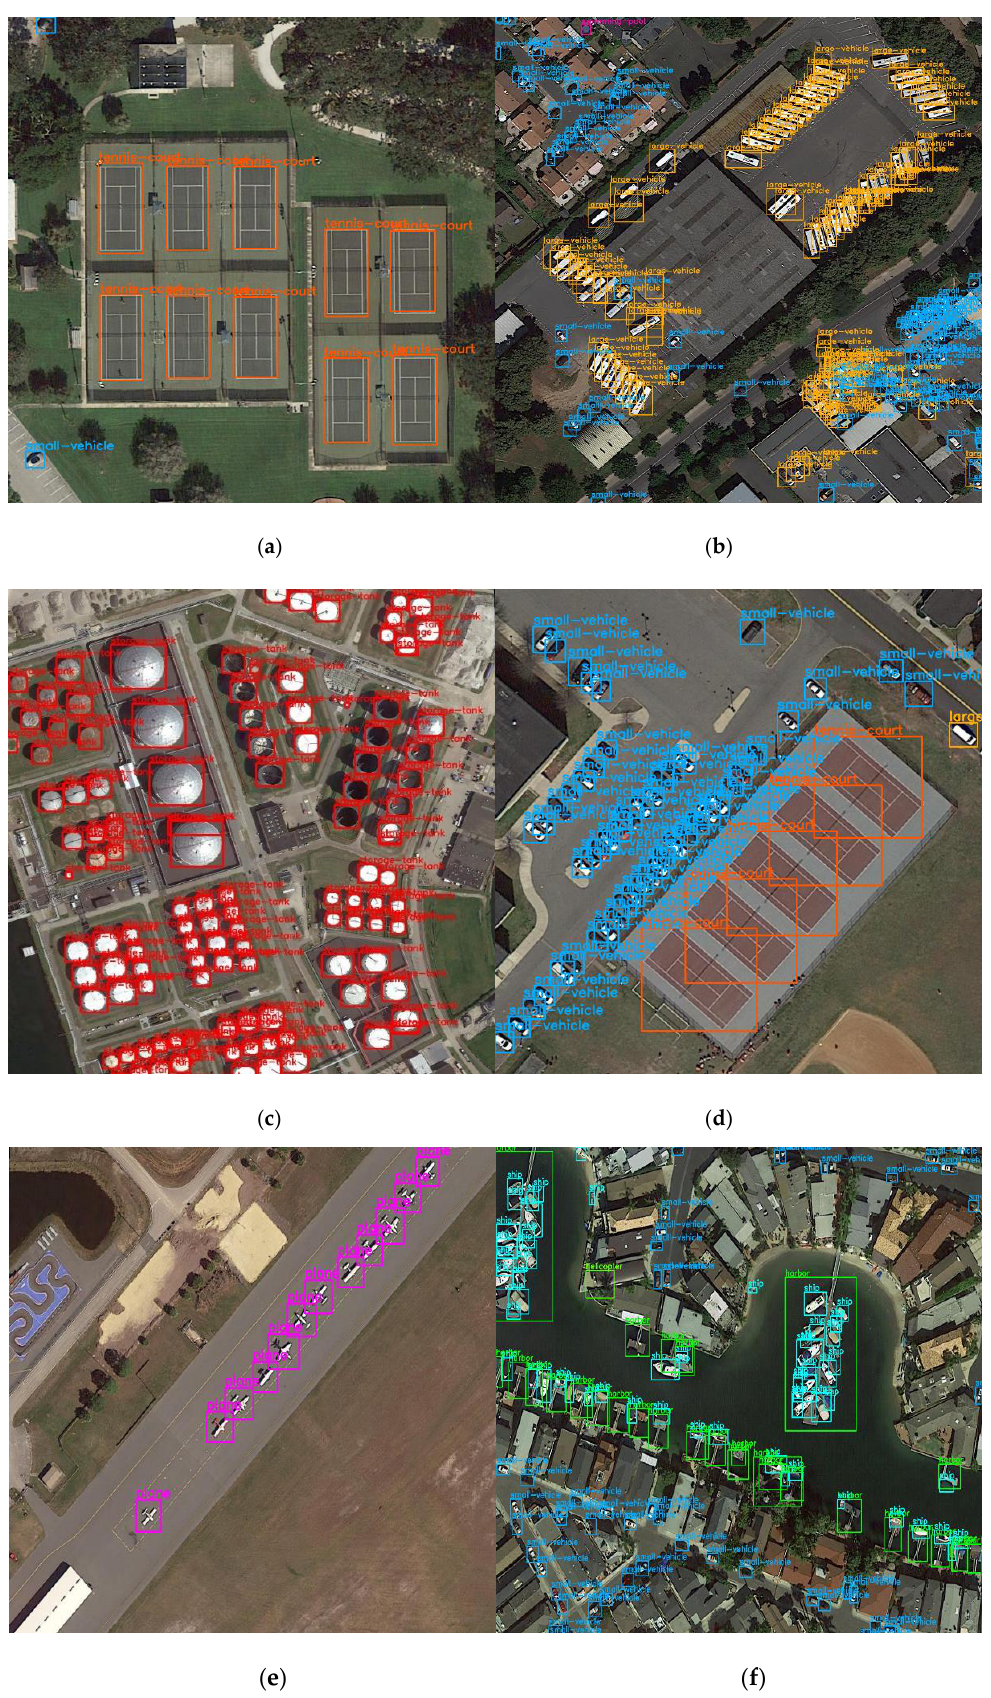
Figure 14. Some results on the DOTA dataset that were detected by our hardware architecture on Xilinx ZYNQ xc7z035